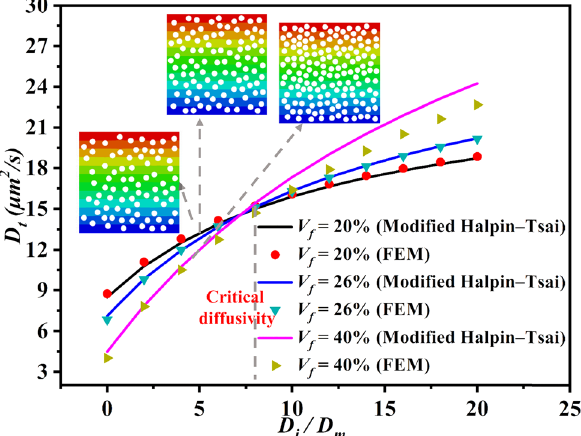
Table 3: Water absorption parameters for di ff erent specimens